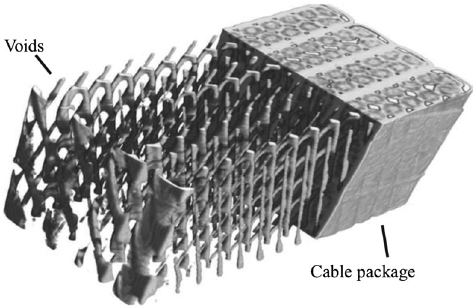
FIG. 1. 3D image from neutron tomography of cable interstices in a stack of Rutherford-type cable [8].